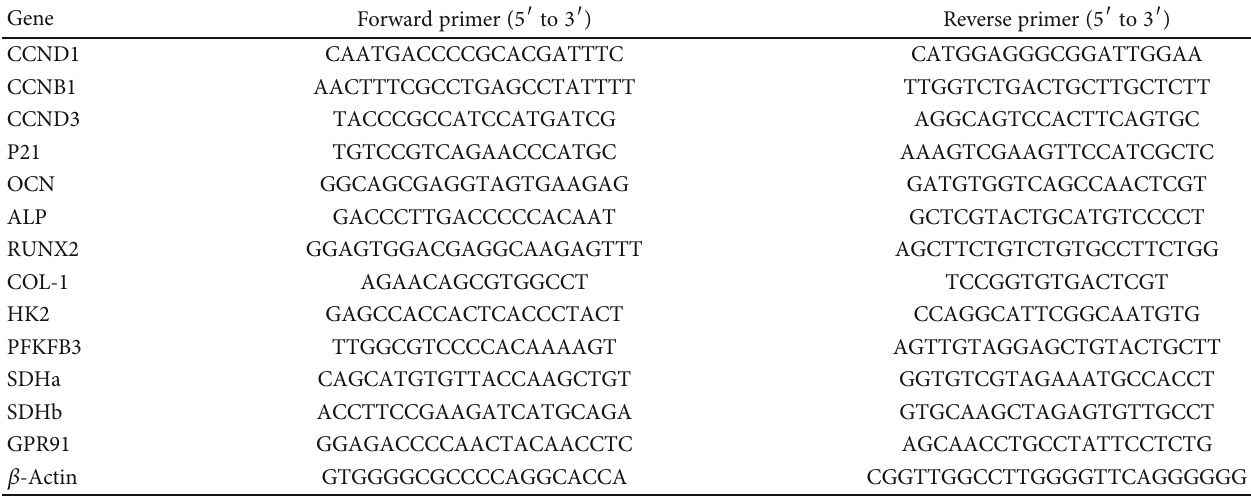
Table 1: Nucleotide sequence of primers used in real-time